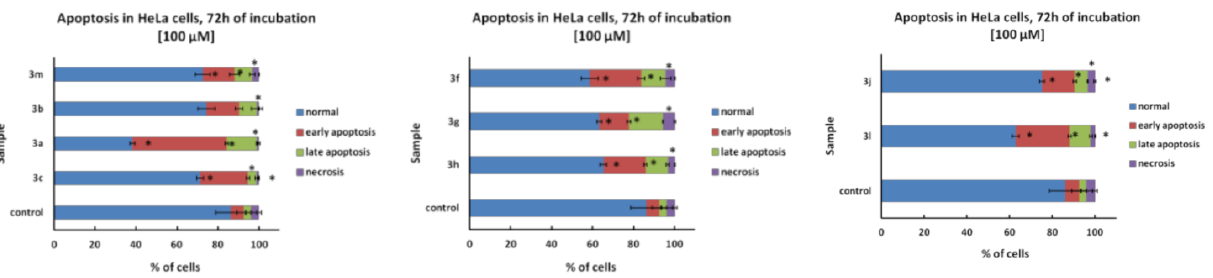
Figure 10. Apoptosis in HeLa after a 72h incubation with compounds with the concentration of 100 µ M. The results were presented as mean value ± SD. The statistical analysis was based on a t-test, and a p-value less than 0.05 was considered statistically significant in comparison to the untreated controls (indicated with a